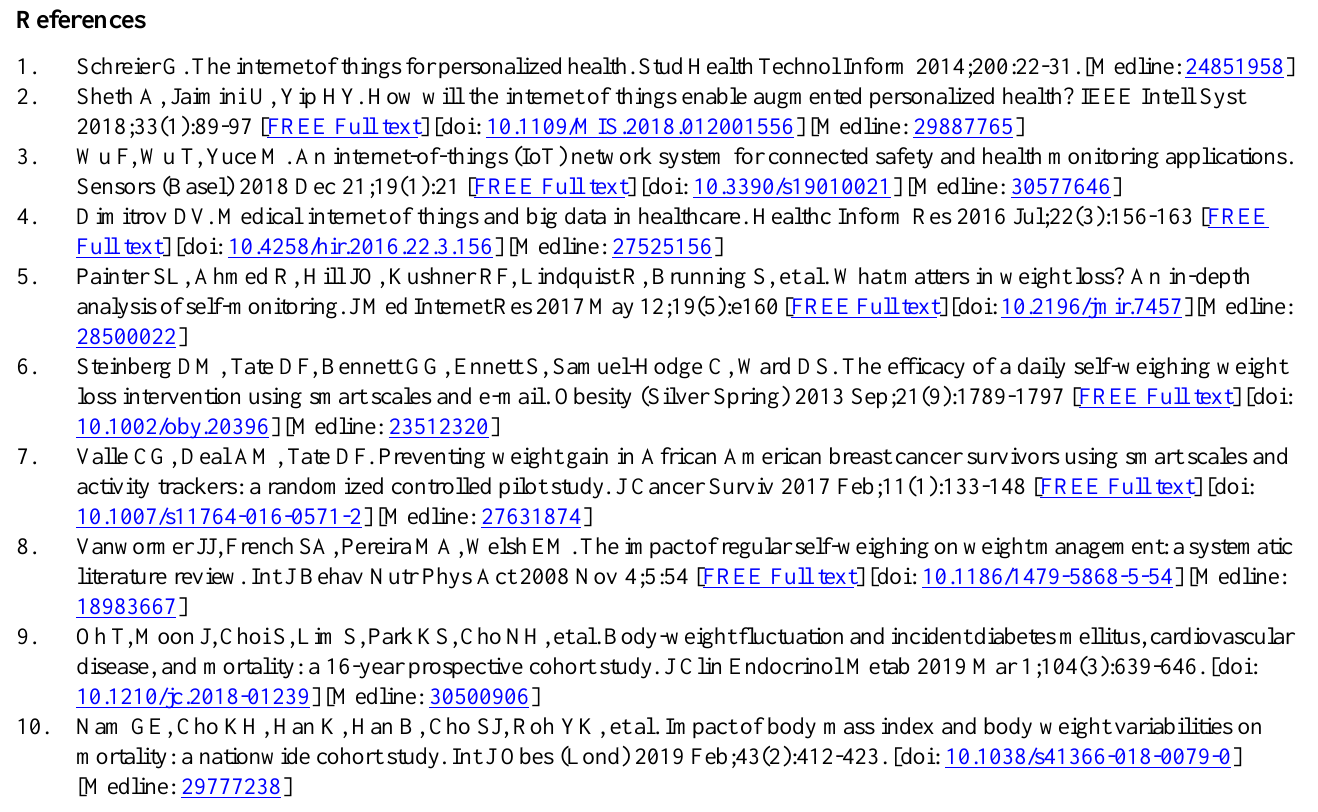
Table of mean errors in body weight variability calculation following simulation and